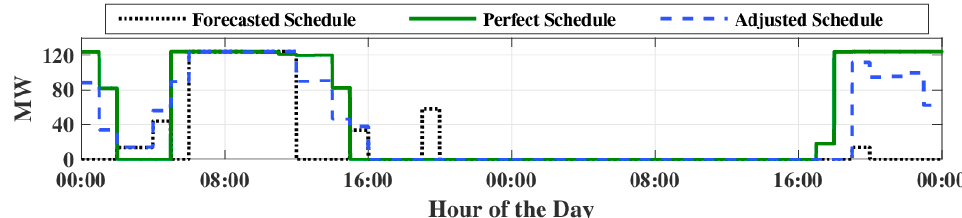
Figure 2. ALFRED deterministic application results: forecasted schedule (optimization algorithm result), adjusted schedule (post-processing result/final schedule), and perfect electricity schedule for two example days [20].